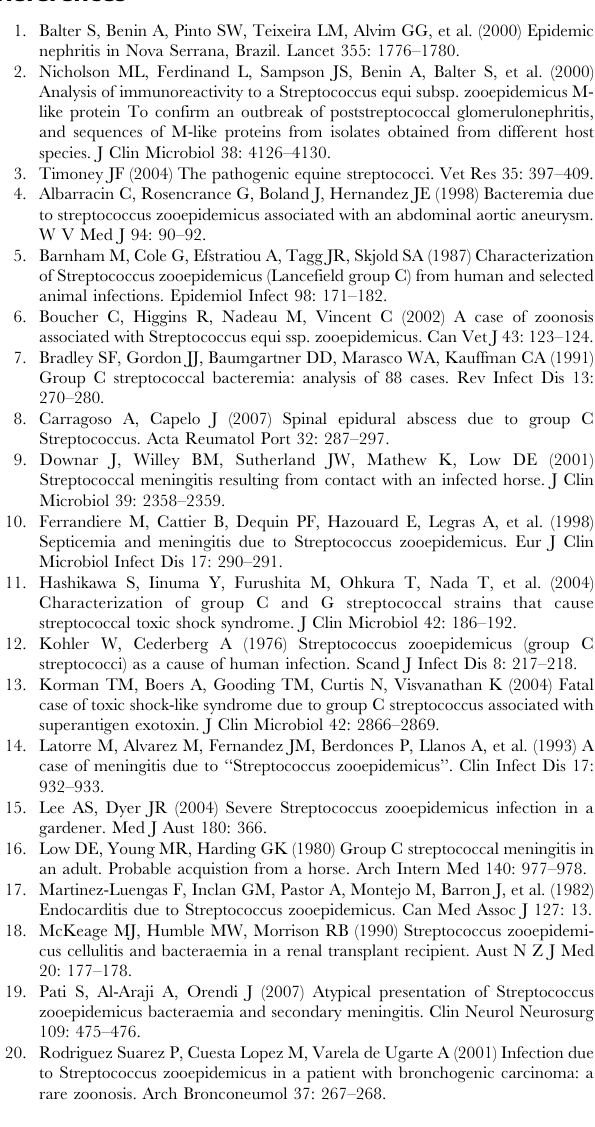
Table S5 Two component system regulator genes Table S6 Proven and putative virulence factor